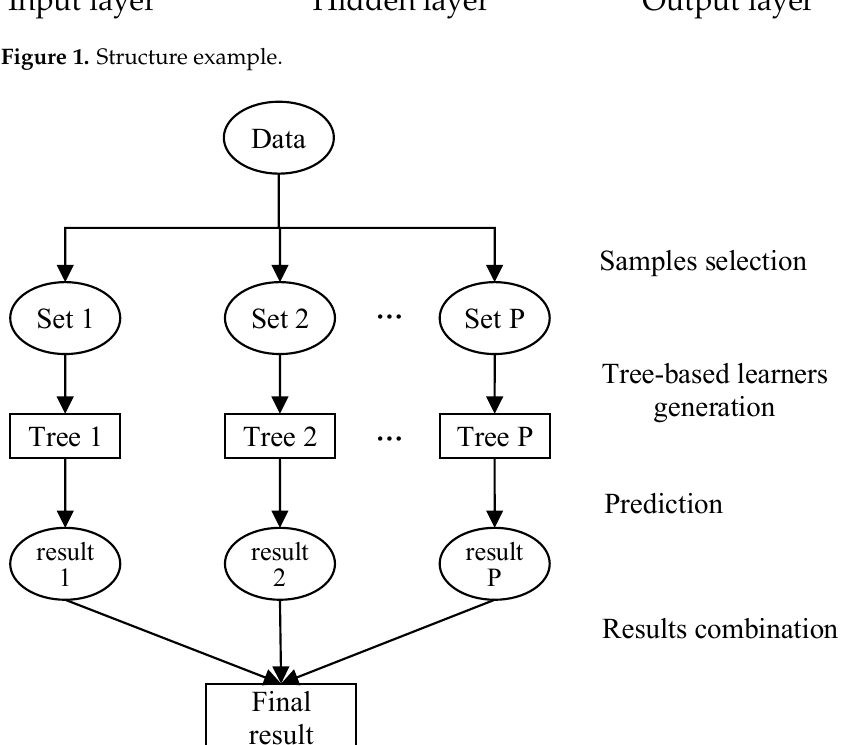
Figure 2. Modeling process of Random Forest. The regression result is obtained by averaging the predicted results of these combined